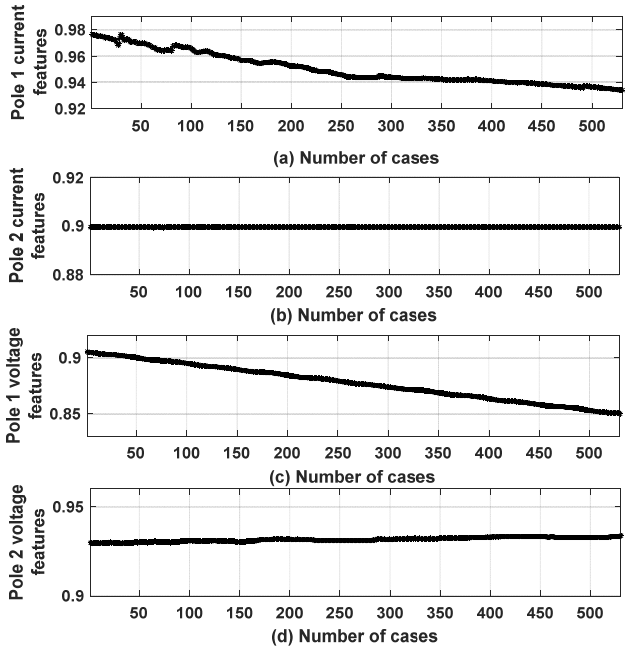
Figure 6. Input features obtained during P1G fault varying different fault location.